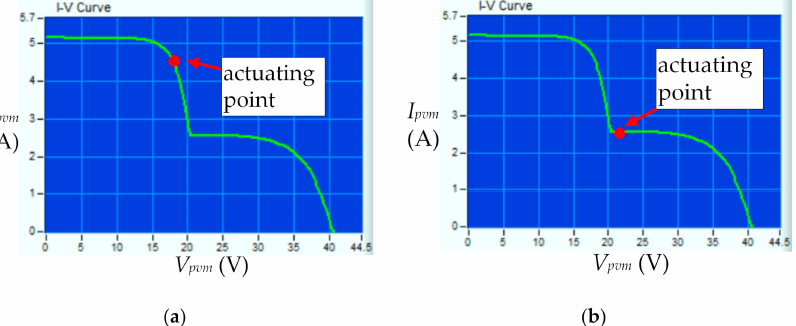
Figure 12. Experimental waveforms of PVM I pvm – V pvm characteristic curves under PSC that T = 25 ◦ C and G = 1 kW/m 2 : ( a ) proposed PVM-QR MPPT and ( b ) HC algorithms.